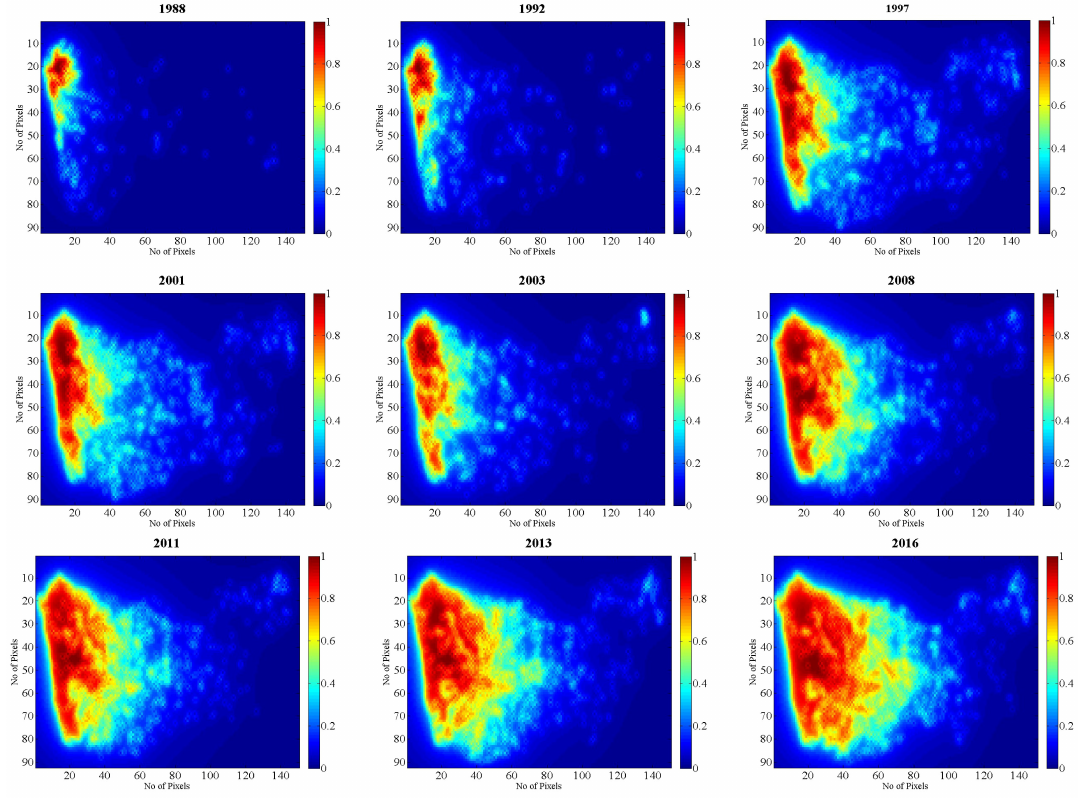
Figure 10. Gravity model of urban density from 1988 to